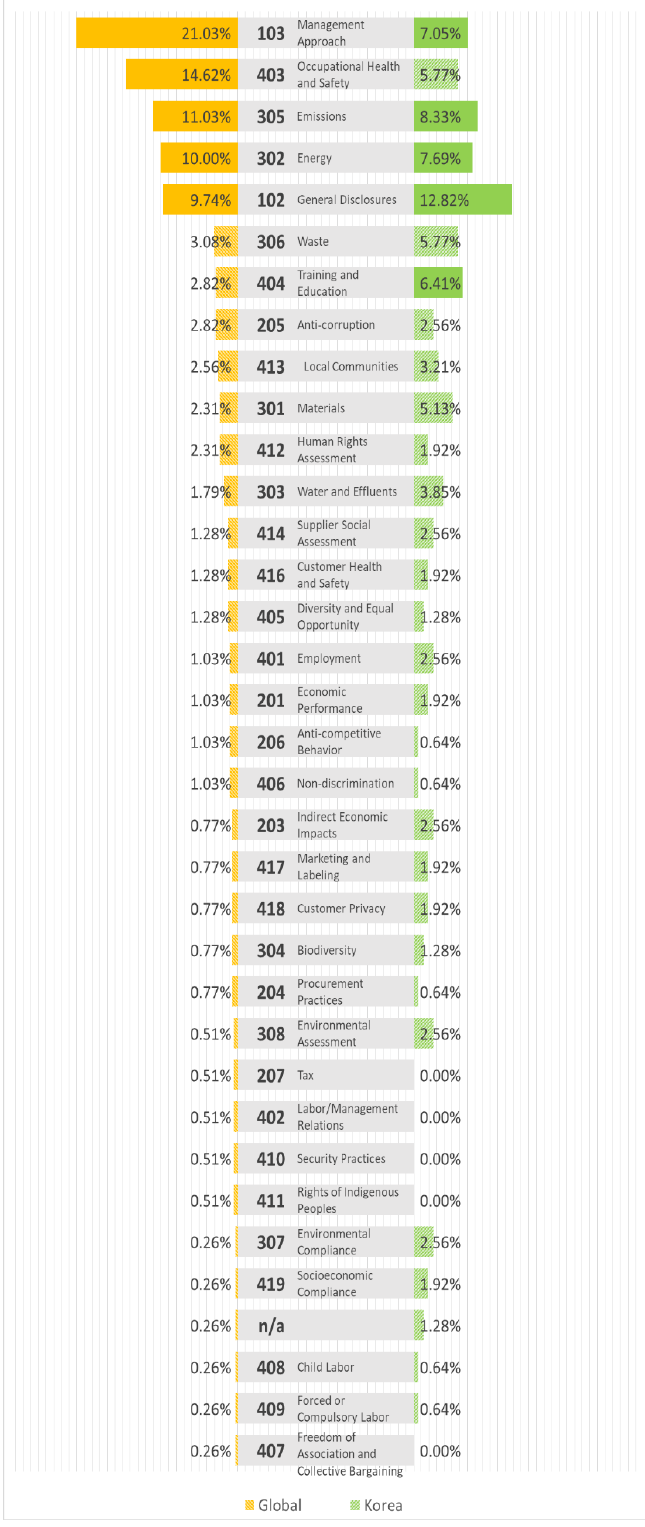
Figure 1. Frequencies of GRI items compared between global and South Korean construction com- panies.